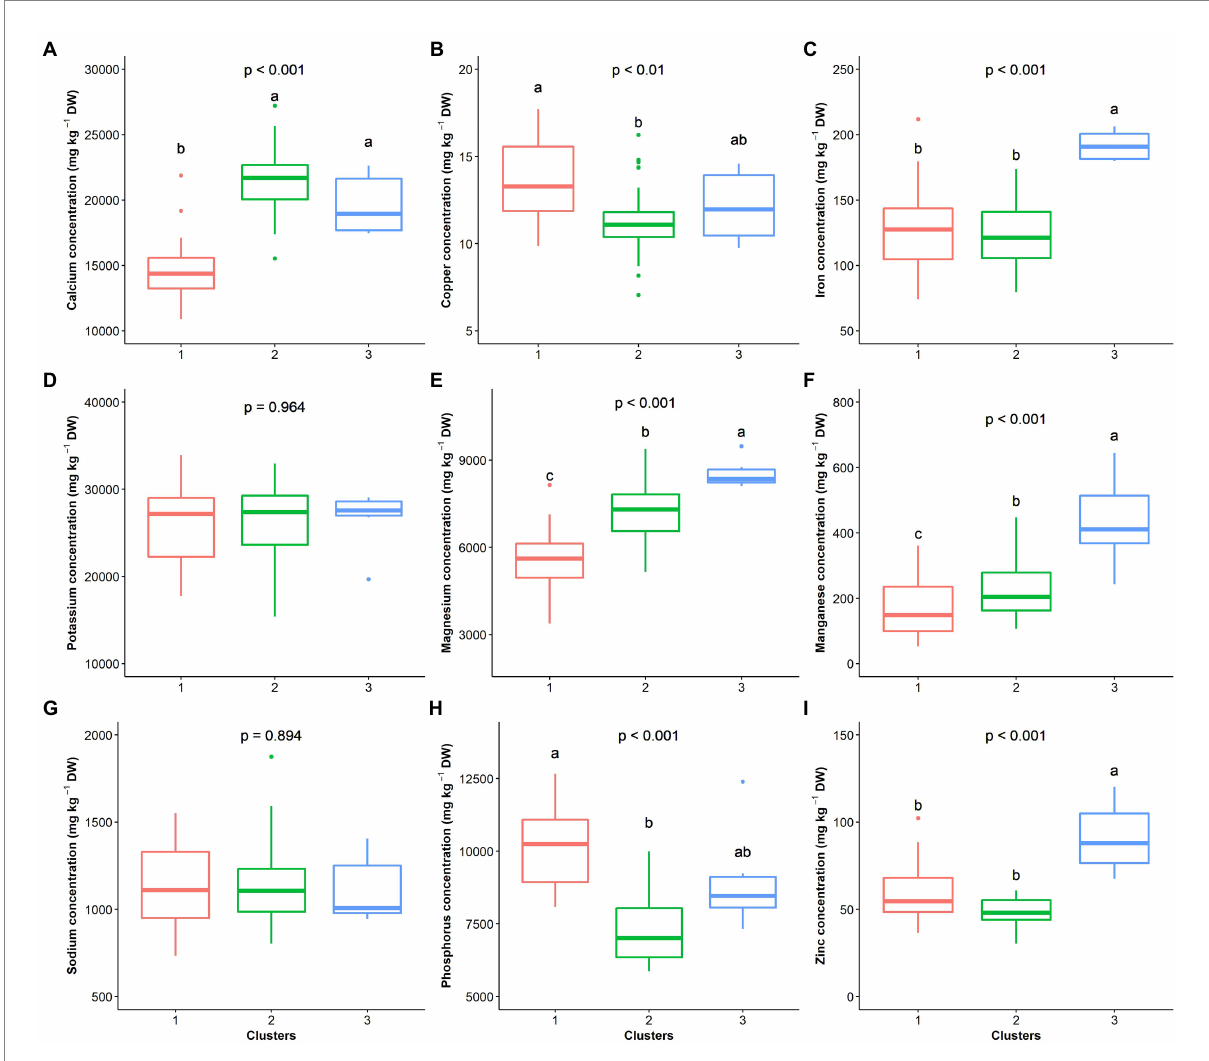
FIGURE 7 Clusters’ performance comparison based on nine elemental compositions of the leaf of G. gynandra . (A) Calcium content; (B) Copper content; (C) Iron content; (D) Potassium content; (E) Magnesium content; (F) Manganese content; (G) Sodium content; (H) Phosphorus content; and (I) Zinc content. Cluster 1 ( n = 31), Cluster 2 ( n = 33) and Cluster 3 ( n = 6). Boxplots with the same alphabetic letter are not significantly different at p < 0.05 according to Dunn’s post-hoc